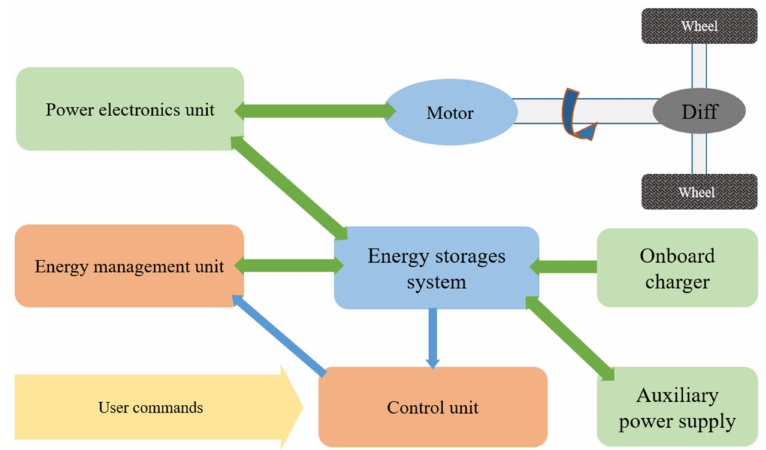
Figure 1. Vehicle powertrain